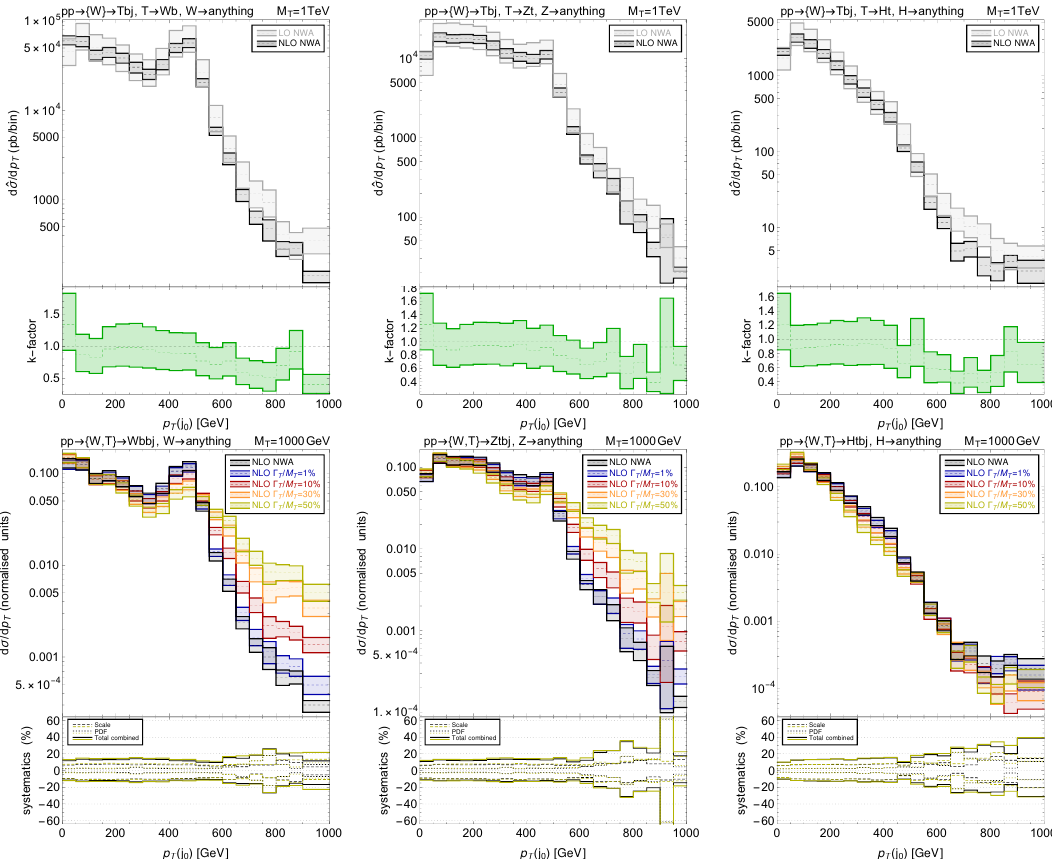
Figure 13 . Distribution of the transverse momentum of the leading jet for single T production in association with a jet. We fix m = 1000 GeV, and we consider the three channels pp → { W, T } → T Wbbj (left), pp → { W, T } → Ztbj (centre) and pp → { W, T } → htbj (right). The top row compares the {LO,NWA} and {NLO,NWA} distributions after factorising out the production coupling (i.e. the y -axis represents the values of the bare cross section ˆ σ VLQ defined in eq. (3.15)), and it bW,tZ,th additionally includes the bin-by-bin K -factor resulting from the ratio of these two predictions. In the bottom row a comparison is made between the {NLO,NWA} and the {NLO,LW} distributions for Γ = 1% (i.e. equivalent to approximately the NWA), 10%, 30% and 50%. The error T /M T bands in the upper panel combines scale and PDF uncertainties, while in the lower panel both their individual relative contributions are shown, together with their combination for the NWA and largest width (50%)